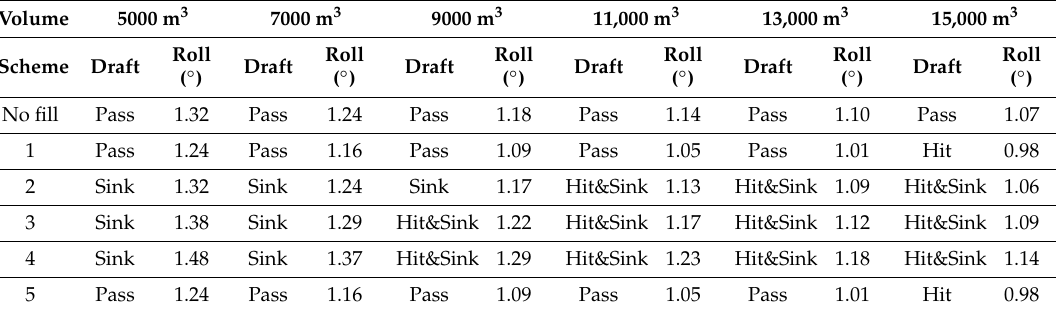
Table 7. Results of storage tank with D / H = 1.5, L / D = 1.05.